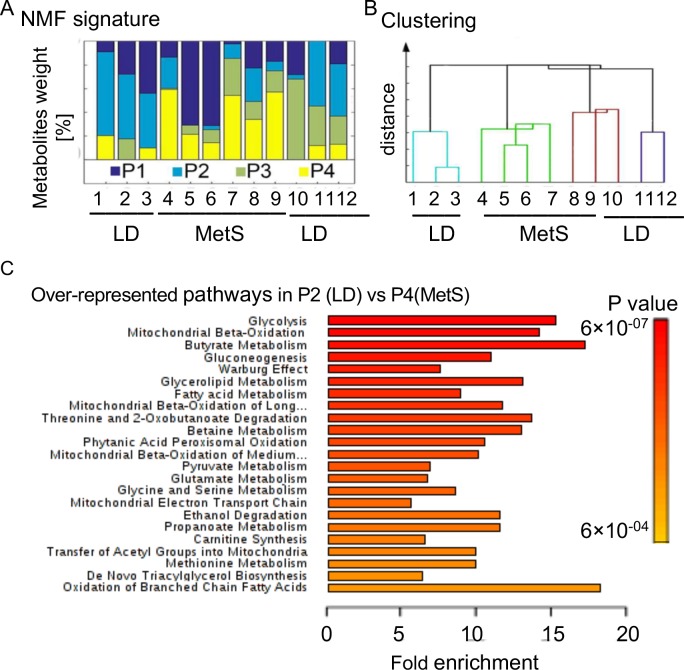
Metabolomic signatures of the myocardial response to diet are obtained by NMF.LC/MS-MS was applied to individually identify and measure polar metabolites (280 polar metabolites) in left ventricular cardiac tissue from Yorkshire intact male swine (MetS n = 6, LD n = 6). (A) Based on the LC/MS-MS derived 12 pig data sets of 280 polar metabolites, NMF extracted signatures of metabolic processes that clearly defer in MetS vs LD. The identity of the individual pigs is shown below the bars. The signatures P1, P2, P3, and P4 are shown in color below the bars. (B) Cluster dendrogram generated by unsupervised hierarchical clustering based on contributions of the four signatures identified by NMF to the metabolomics database of the 12 swine (cophenetic correlation coefficient 0.92). (C) Over-represented known pathways in the P2 (LD) signature vs. MetS signature (P4) are determined in MetaboAnalyst 4.0. Their p values are shown with the colored bar diagram on right.